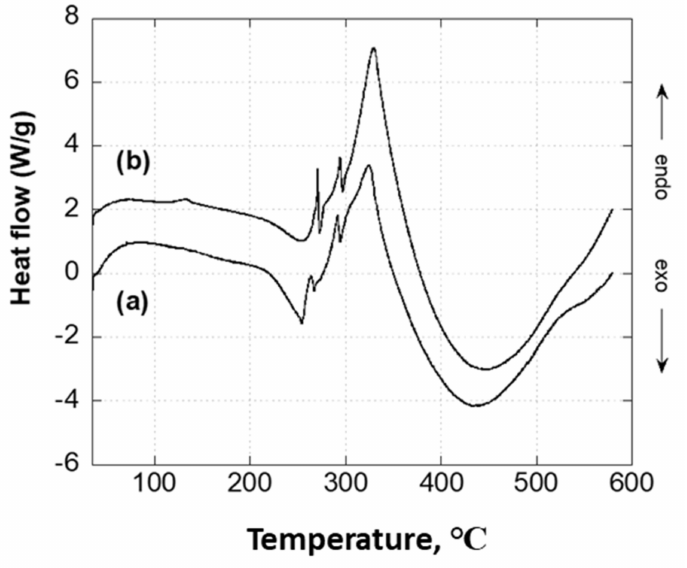
Figure 9. DSC curves of [Zn(4,4 (cid:48) -bipy) 2 (OAc) 2 ] ∞ samples prepared by the sonochemical process: ( a ) sample A; ( b ) sample